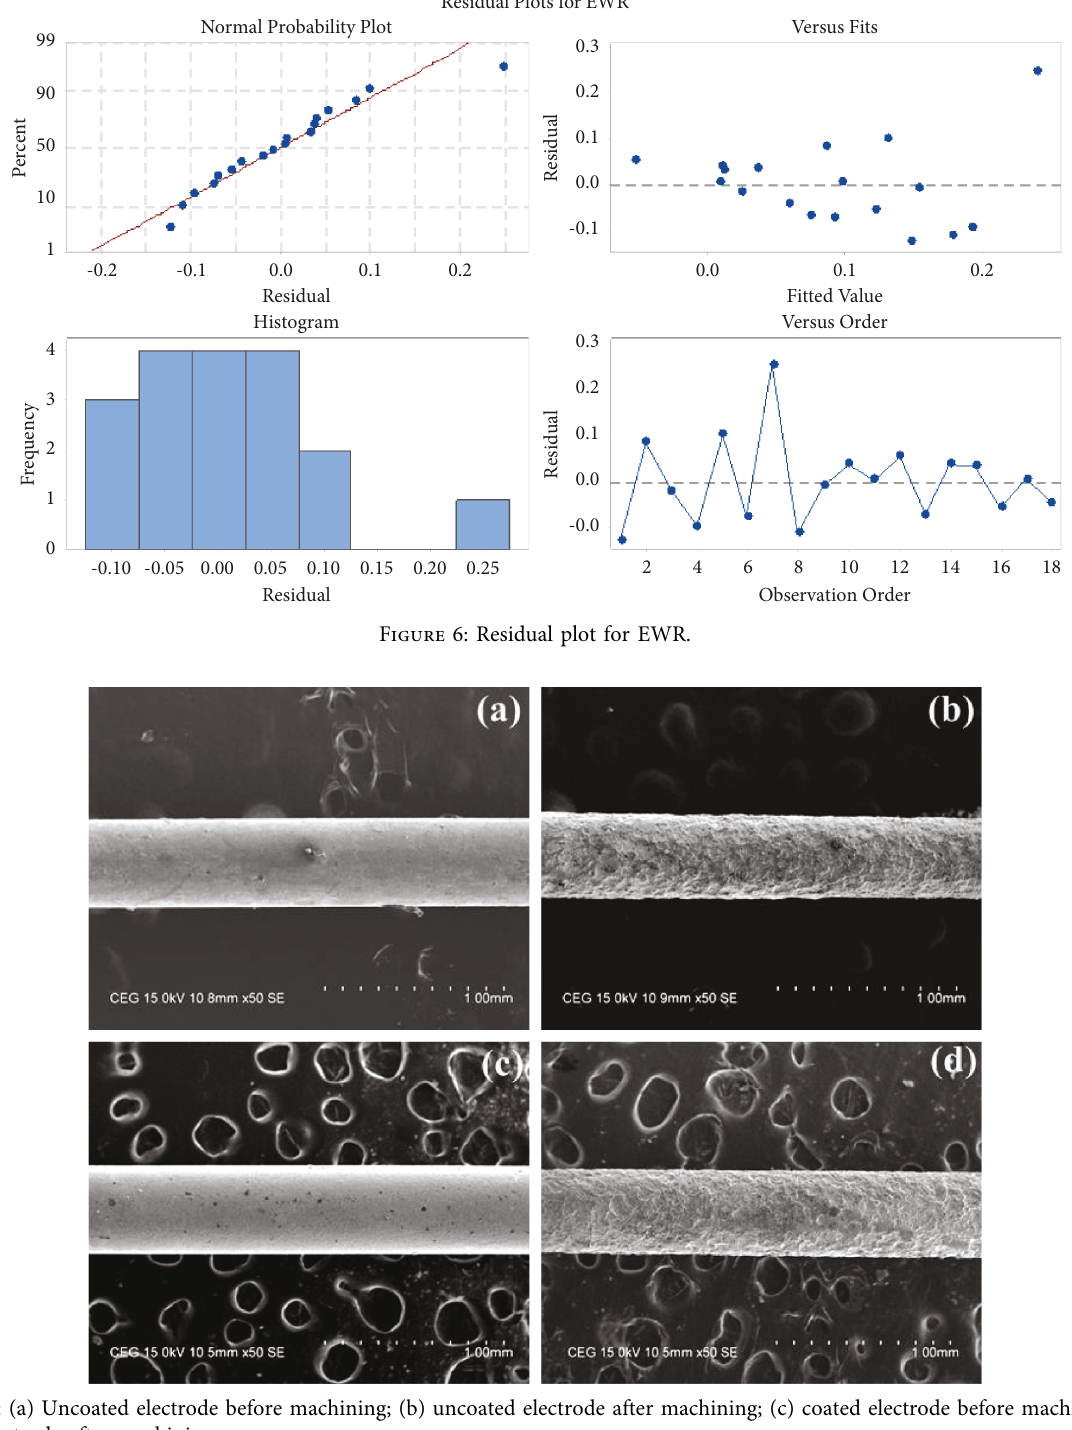
Figure 7: (a) Uncoated electrode before machining; (b) uncoated electrode after machining; (c) coated electrode before machining; (d) coated electrode after